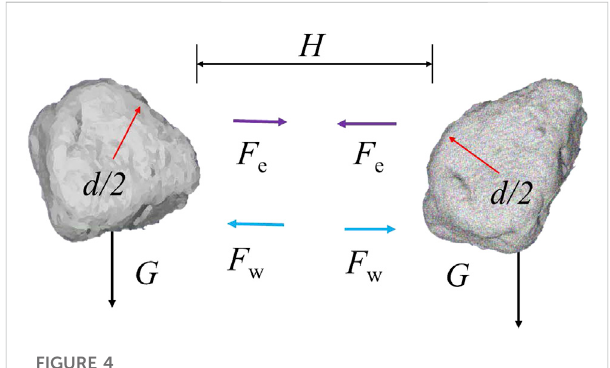
FIGURE 4 Microscopic force between